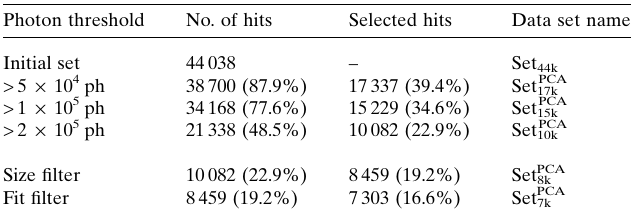
Table 1 Data sets selected for different photon thresholds with the subsequent PCA selection. The percentages of the selected data to Set 44k are given in parentheses. Photon